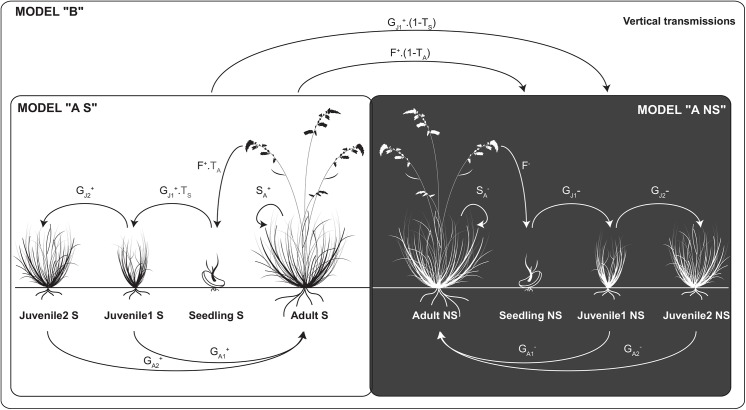
Diagram of the life cycle model for Festuca eskia populations including symbiotic and non-symbiotic plants.The model can be broken down into three submodels, according to the endophytic status of the plants present in the population: AS, ANS and B. Globally, the model includes four symbiotic stages (Seedling S, Juvenile 1 S, Juvenile 2 S, Adult S), four non-symbiotic stages (Seedling NS, Juvenile 1 NS, Juvenile 2 NS and Adult NS), two probabilities for transitions between S and NS stages (Vertical transmissions: TS from seedling S to Juvenile 1 NS; TA from adult S to seed NS,), two fecundity arcs (F+ and F-), two survival probabilities (SA
+ and SA
-) and eight growth transitions (GJ1
+, GJ1
-, GJ2
+, GJ2
-, GA1
+,GA1
-,GA2
+, GA2
-).